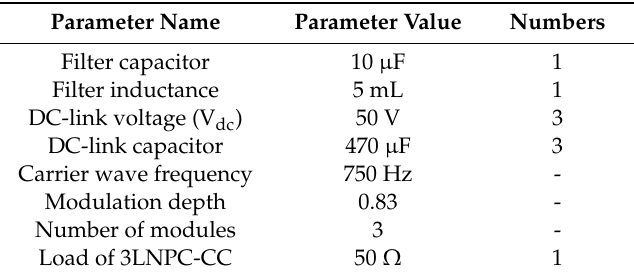
Table 5. Prototype Parameter.